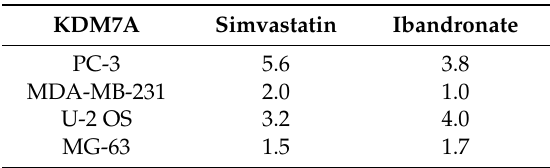
Table 12. Fold upregulation of histone demethylase KDM7A